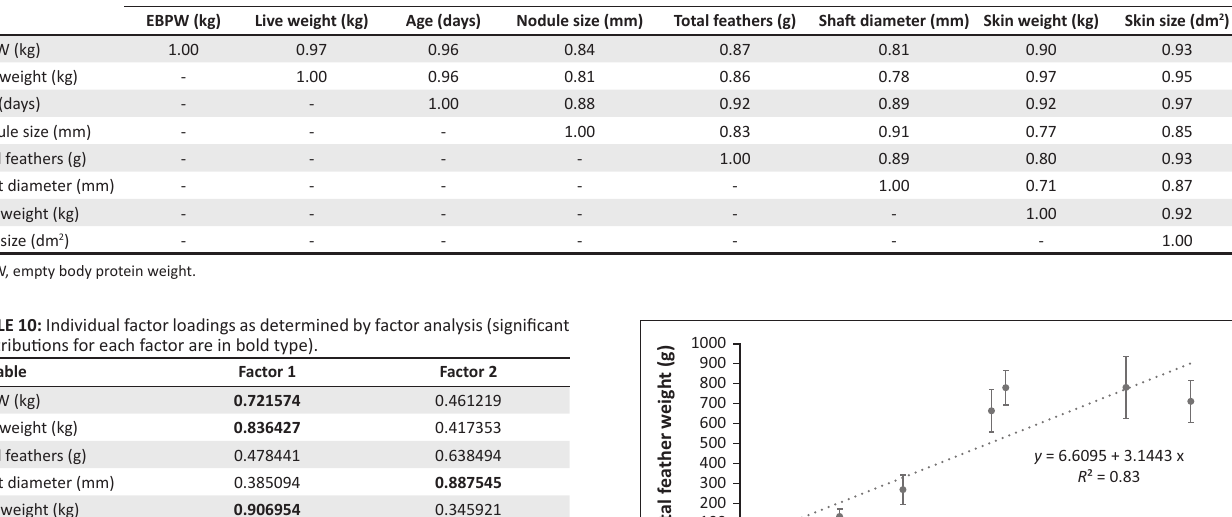
TABLE 9: Correlation coefficients (r) between the measured explanatory variables affecting nodule size. All correlations are significant at p < 0.05. Variable